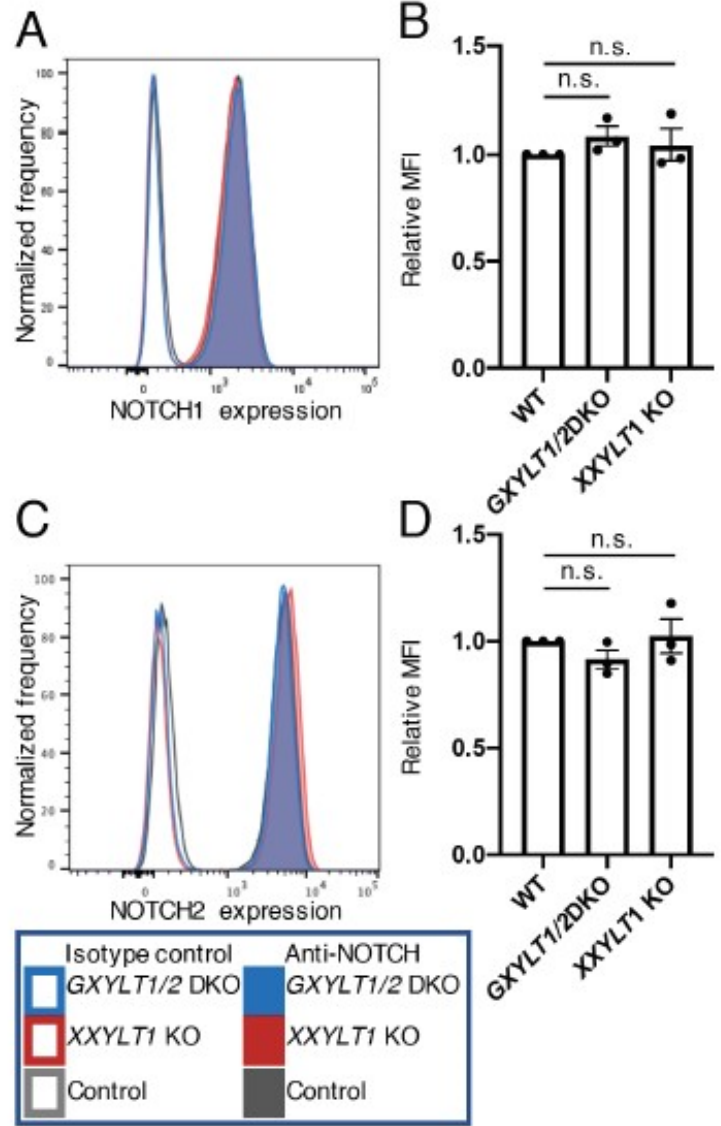
Figure 4. XYLTs are not required for the cell surface expression of endogenous NOTCH1 and NOTCH2 in HEK293T cells. ( A ) Histograms of endogenous NOTCH1 expression in wild type and XYLTs ’ KO clones of HEK293T cells analyzed by flow cytometry. ( B ) Mean fluorescence intensity from ( A ). Plots are from three independent experiments ( n = 3). Error bar denotes the standard error of the mean (SEM). Bar graphs show the average ± SEM. ( C ) Histograms of endogenous NOTCH2 expression in wild type and XYLTs ’ KO clones of HEK293T cells analyzed by flow cytometry. ( D ) Mean fluorescence intensity from ( C ). Plots are from three independent experiments ( n = 3). Bar graphs show the average ± SEM. The cell numbers on the vertical axis of the graphs for ( A , C ) are normalized with the mode value. n.s., not significant ( p > 0.05).